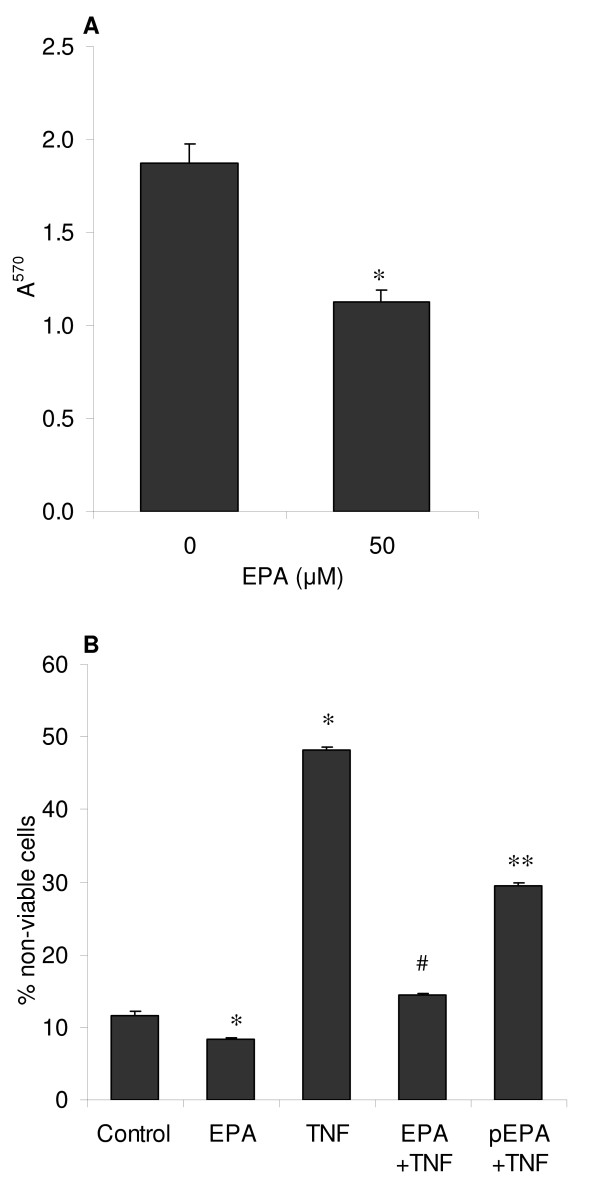
EPA ameliorates baseline and TNF-α-induced cellular necrosis. Any potential cytotoxic effect of EPA on C2C12 myotube formation was investigated after 5 days following induction of differentiation by DM using a CellTiter Blue assay to detect all non-viable cells (A). The effect of TNF-α (20 ng/ml) on cellular necrosis and the ability of EPA to block this activity were also assessed by Trypan Blue dye exclusion to detect necrotic cells (B). Here, EPA was added together with TNF-α as a co-treatment (EPA+TNF) or, alternatively EPA was administered alone for a 2 hour pre-treatment after which it was withdrawn and replaced by TNF-α alone in DM (pEPA+TNF). Incubations were continued for 5 days in DM with replenishment of EPA and TNF-α at media changes. Data are expressed as means ± standard error of mean (SEM) from 3 independent experiments (*p < 0.05 v. control; #NS v. control; **p < 0.05 v. TNF-α).